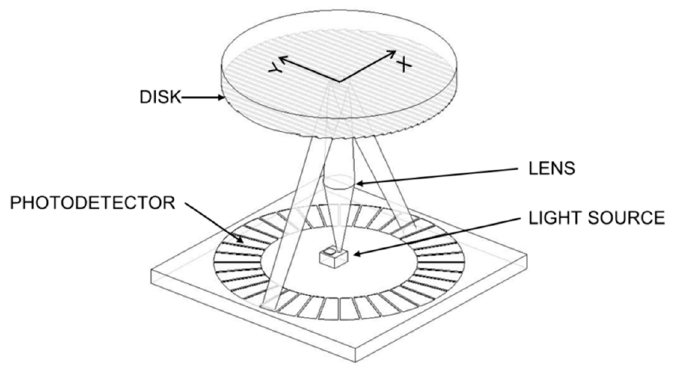
Figure 4. Functional principle of the optical encoder.